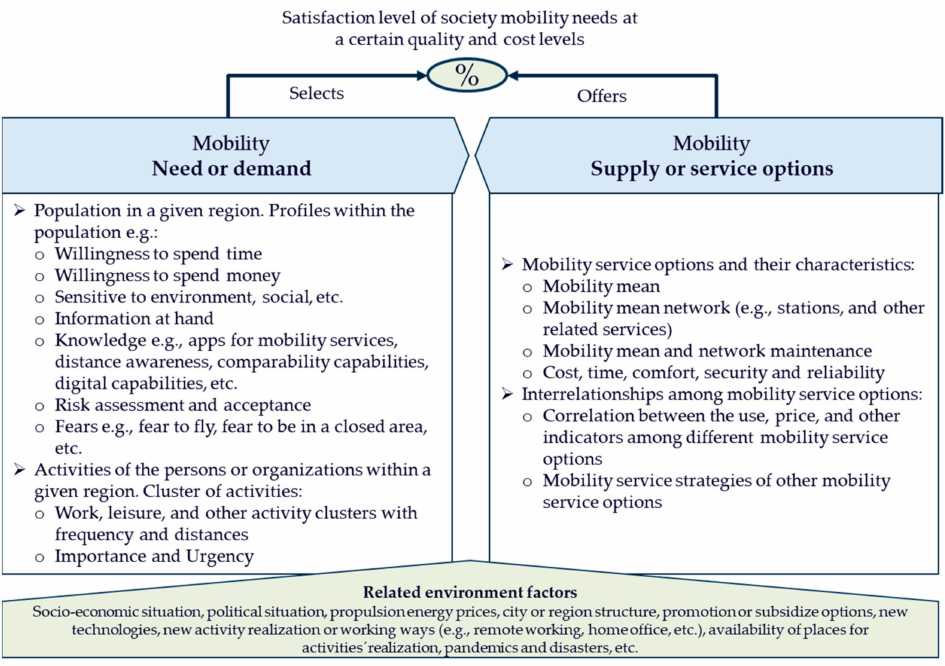
Figure 2. Conceptual framework for Mobility Needs and Supply